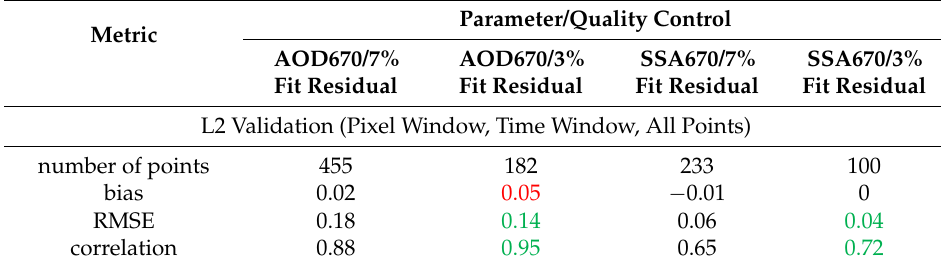
Table 10. Comparison of GRASP/PARASOL AOD and SSA at 670 nm vs. AERONET over Mongu, Banizoumbou, IER_Cinzana, Agoufou, Ilorin sites in Africa for 2008 with two different “fitting residuals” of 7 % and 3 %. Green colors indicate improvement for lower fitting residuals. Parameter/Quality Control Metric AOD670/7% AOD670/3% SSA670/7% SSA670/3% Fit Residual Fit Residual Fit Residual